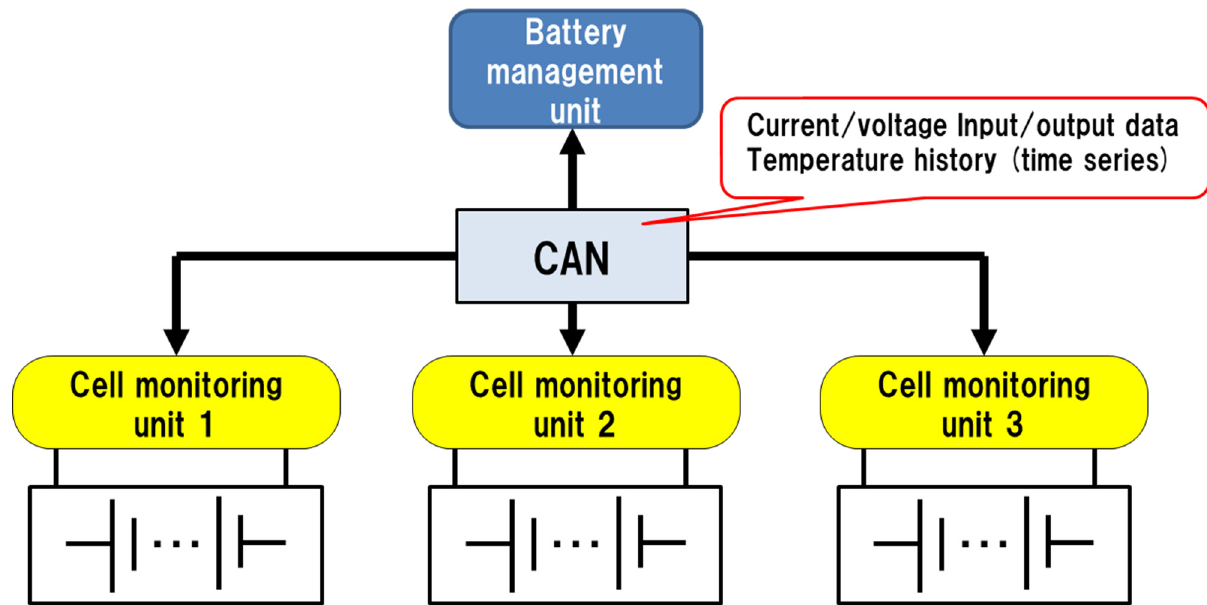
Figure 6. Schematic diagram of the battery controller